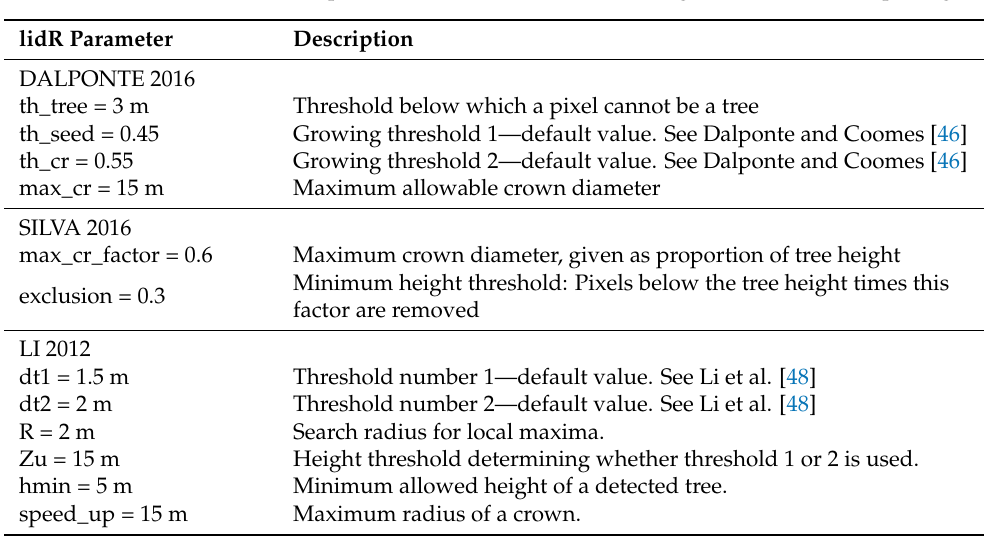
Table 3. Parameters used for Dalponte2016, Silva2016, and Li2012 algorithms in the lidR